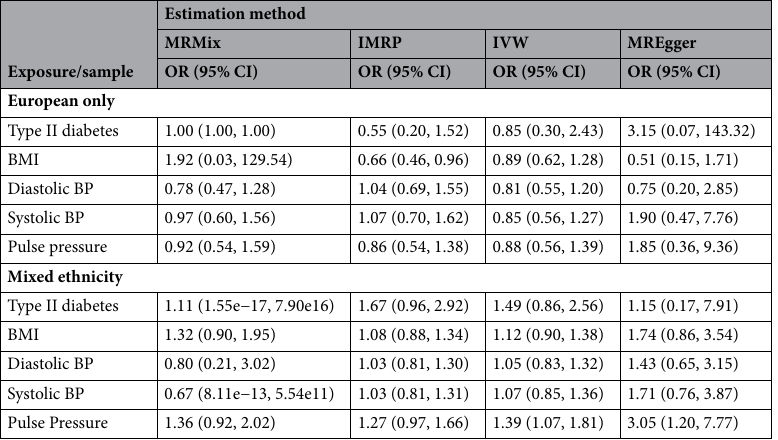
Table 2. Causal effect estimates of each exposure on COVID-19 hospitalization status. Displayed are causal effect estimates for each exposure on COVID-19 hospitalization status within the European sample and multiple ethnicity sample. Estimates are displayed as odds ratios with 95% confidence intervals included in